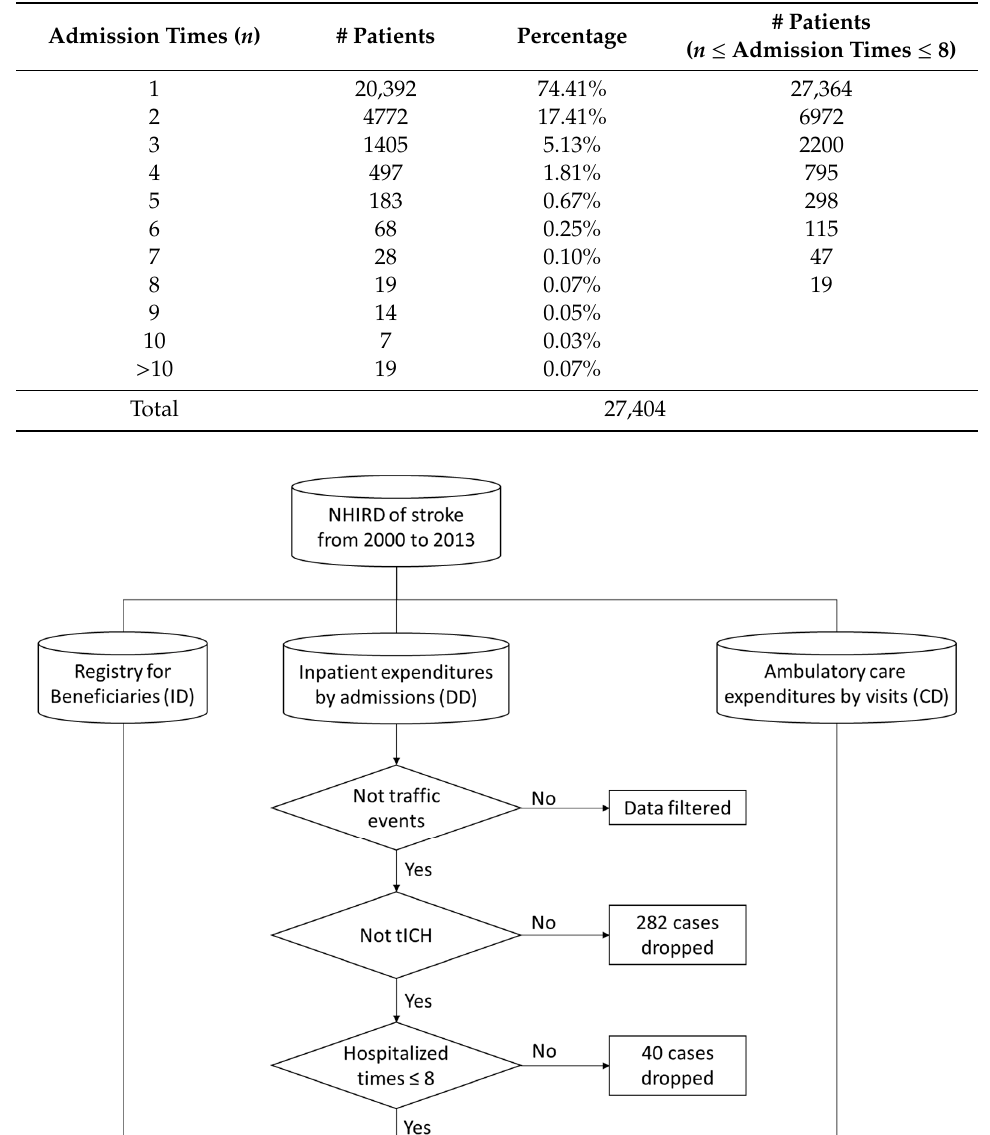
Table 1. Patient hospitalization statistics.